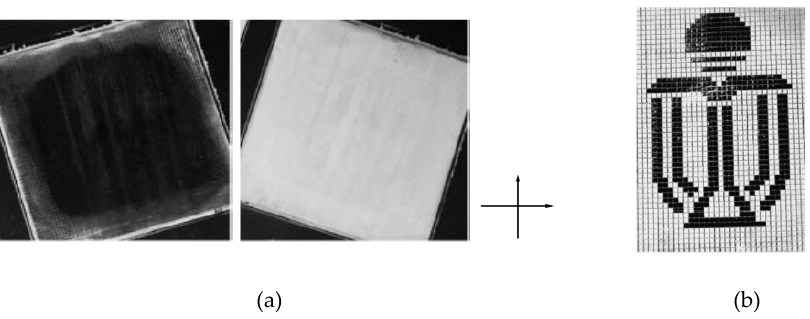
Figure 3. ( a ) FLC-408A-based 1.5 µ m cell between two crossed polarizers, shown by arrows. The light aperture of the cell is 33 × 33 μ m. The dark and bright states are memorized after the driving voltage is switched off. ( b ) The generated image by passively addressed photo-aligned 64 × 64 display, which was memorized after the driving voltage was turned off. The FLC-408A layer thickness is 5 μ m.